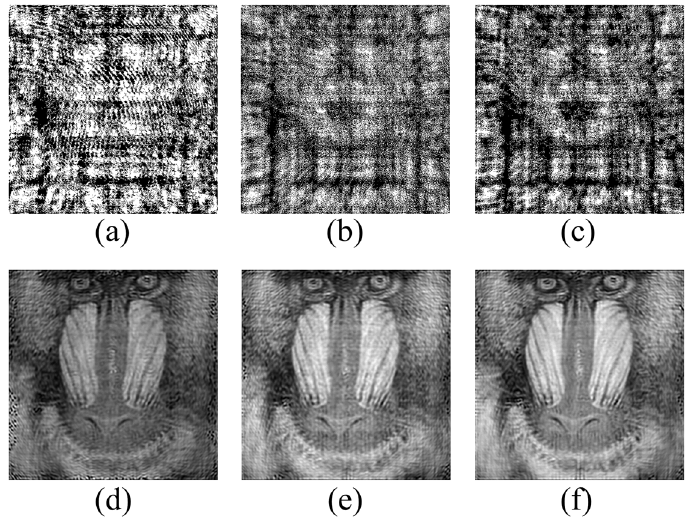
Figure 5. Off-axis BCGHs and the reconstructed images. The BCGHs are produced by DBS ( a ), SA ( b ), and SABS ( c ), respectively. Their reconstructed images are in ( d ), ( e ), and ( f ), respectively. ( g ) is the target image.